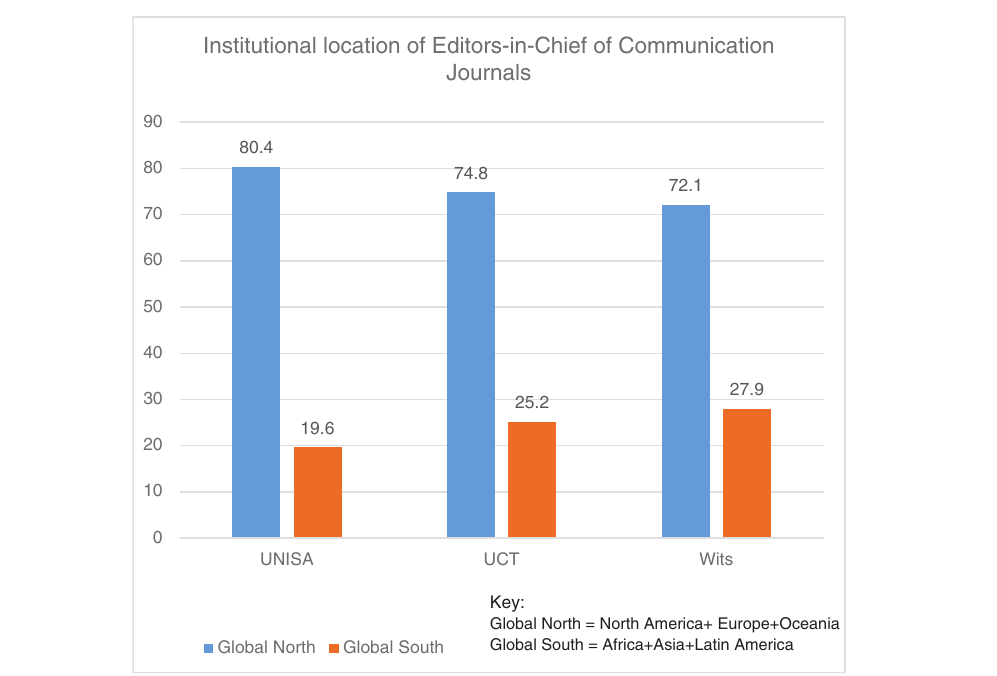
Figure 3: Distribution of institutional affiliation of editors-in-chief between the Global North and the Global South (Source: Author,